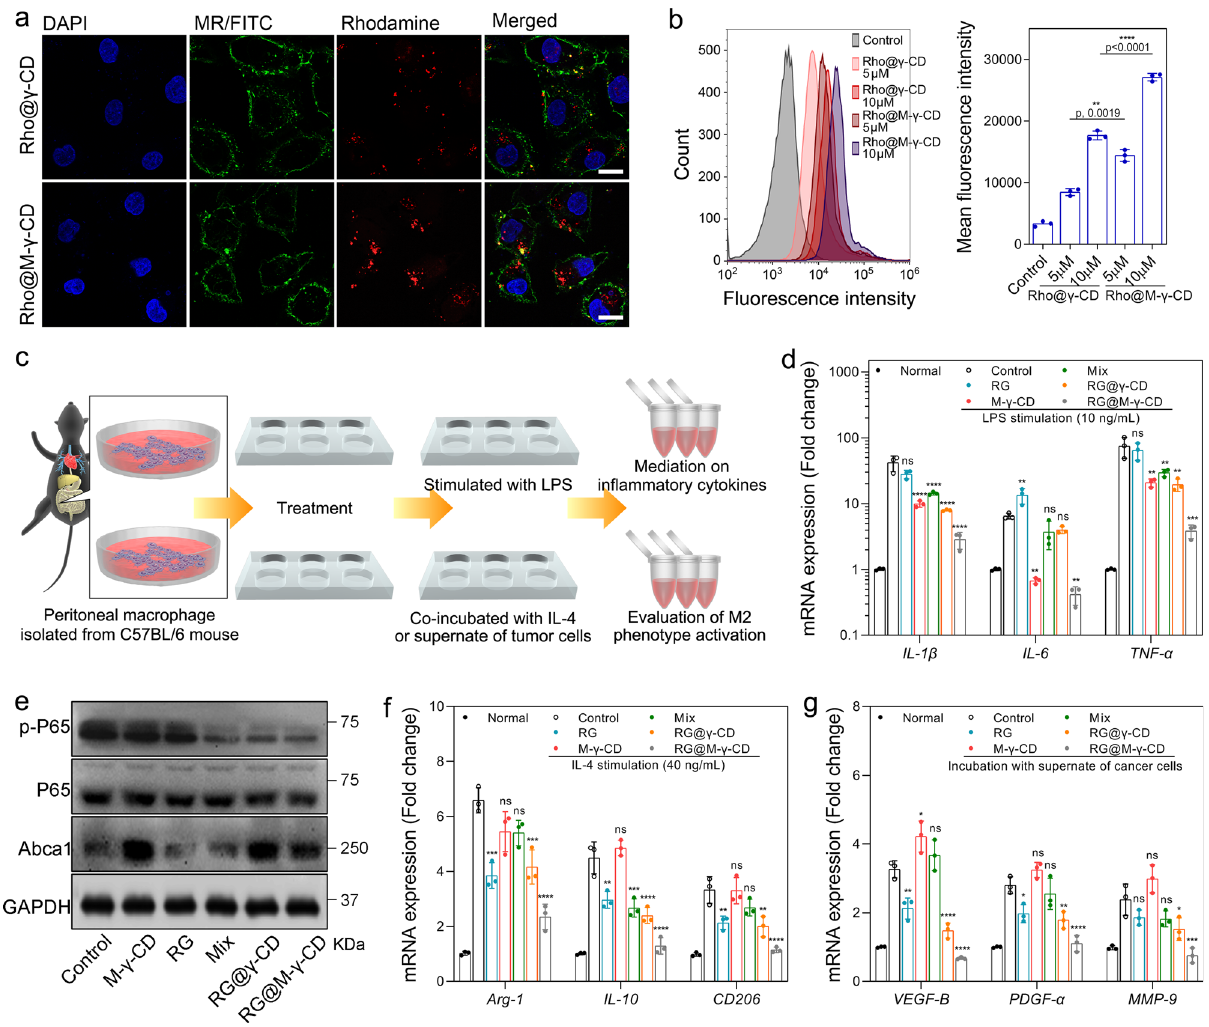
Fig. 4 In vitro regulatory effect of RG@M- γ -CD upon macrophage. Cell internalization of CNPs by macrophages. a Representative CLSM images of the peritoneal macrophages cultured with Rho@M- γ -CD and Rho@ γ -CD CNPs (equivalent Rho, 5.0 μ M) for 2 h. Blue fl uorescence indicated nuclear staining with DAPI; green fl uorescence indicated mannose receptors staining with FITC-antibody; red fl uorescence presented the internalization of CNPs. Scale bar, 20 μ m. b FACS analysis and statistical result of intracellular fl uorescence intensities induced by internalized Rho@M- γ -CD and Rho@ γ -CD (equivalent Rho, 5.0 and 10.0 μ M) in peritoneal macrophages (2 × 10 4 cells/sample). N = 3 biological replicates in each group. Data were presented as means ±